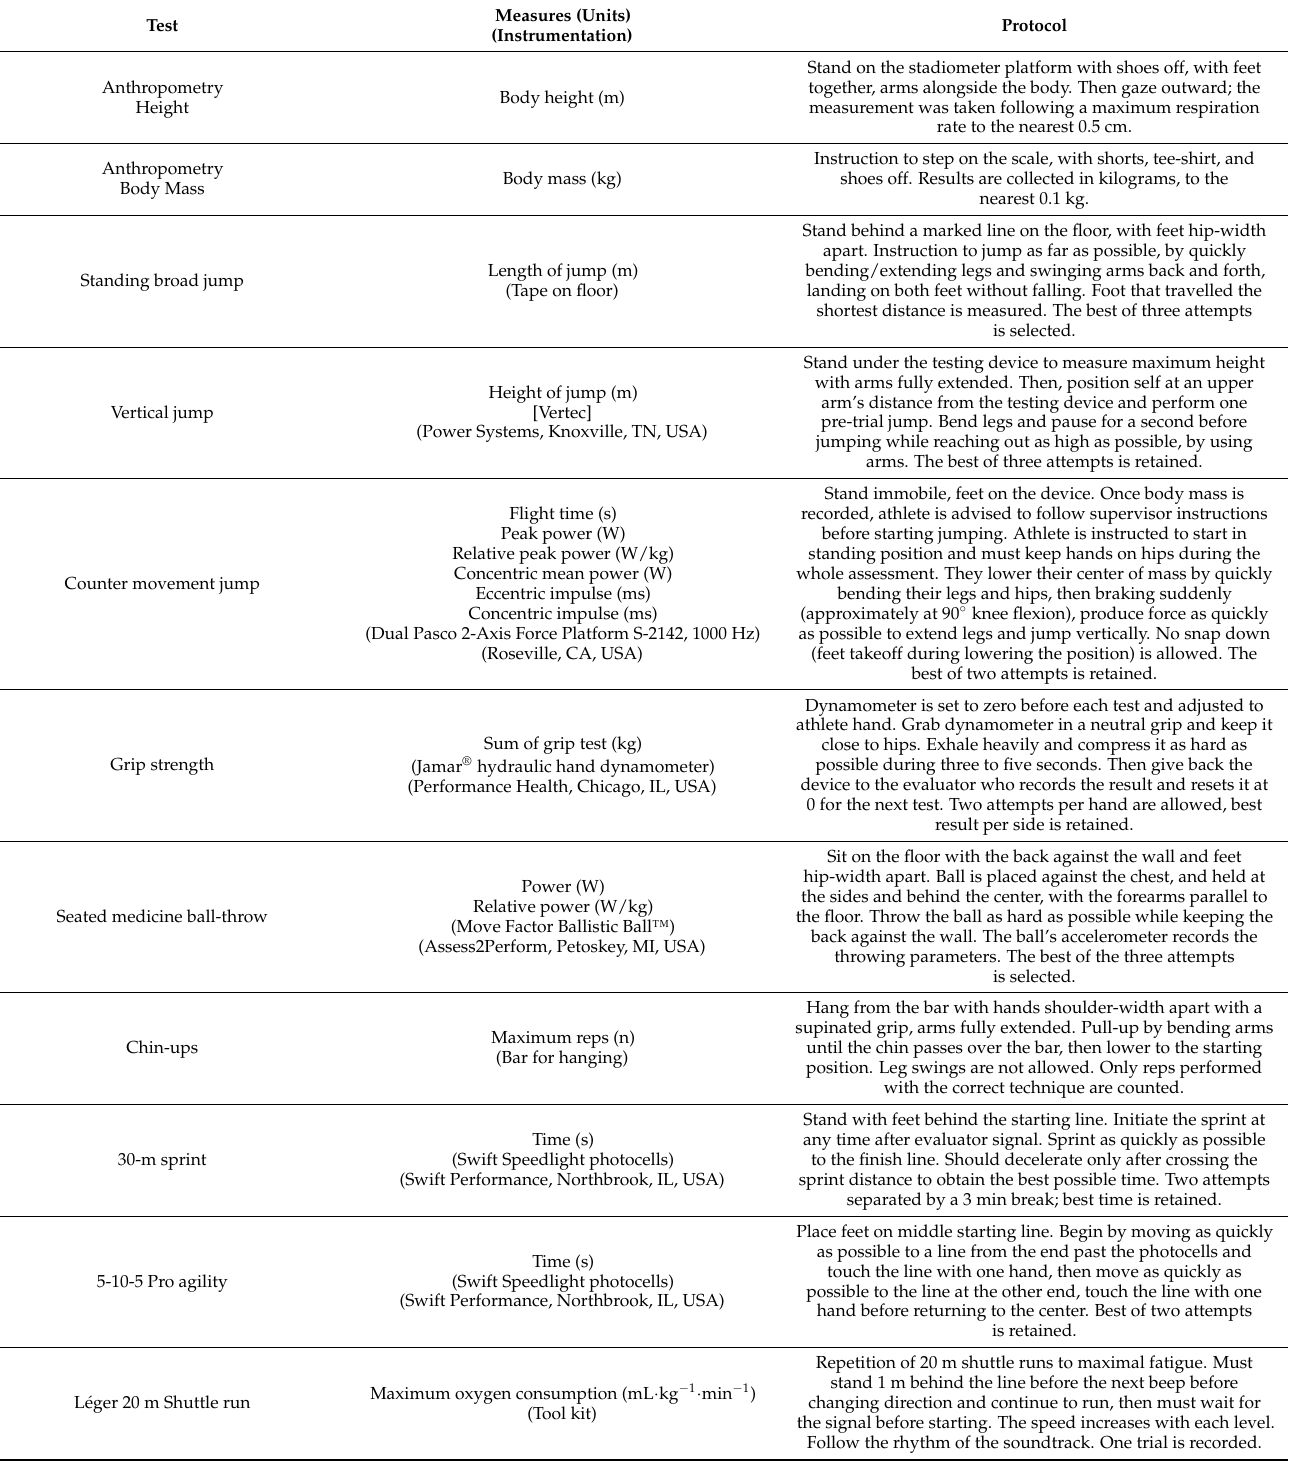
Table A1. Anthropometric and off-ice fitness tests